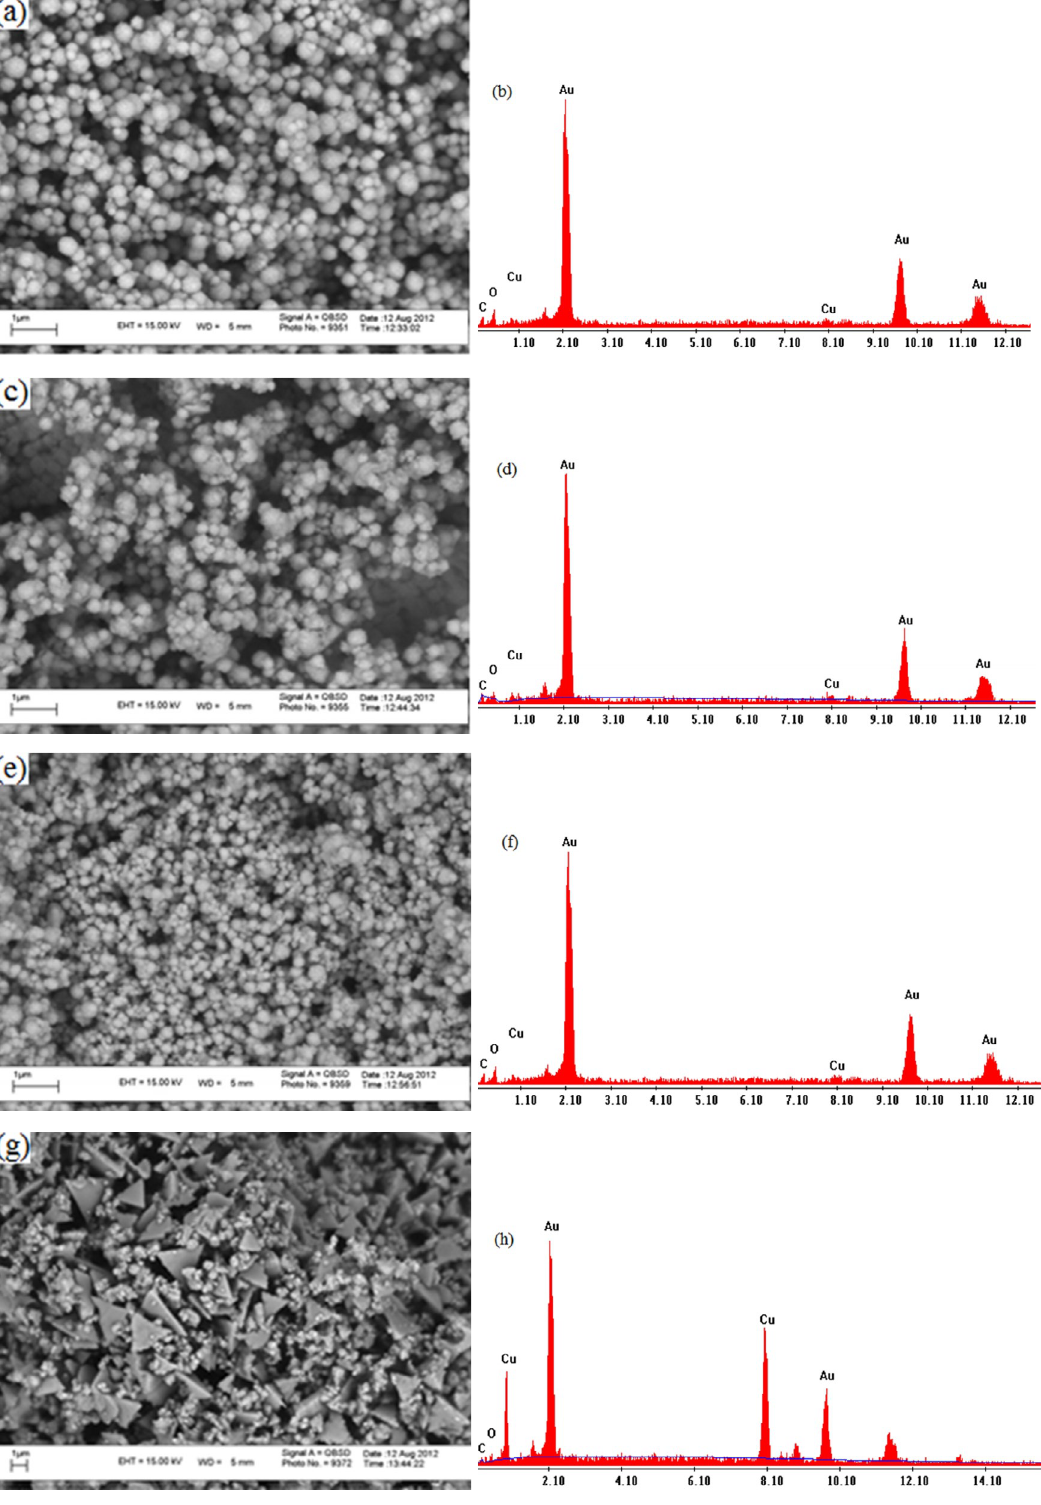
Fig. 1. (a, c, e, g) SEM images of Au-Cu nanoparticles: (a) 10 at%, (c) 25 at%, (e) 50 at% (g) 75 at%. (b, d, f, h) EDAX Spectrum of Au-Cu nanoparticles: (a) 10 at%, (c) 25 at%, (e) 50 at% (g) 75 at%.